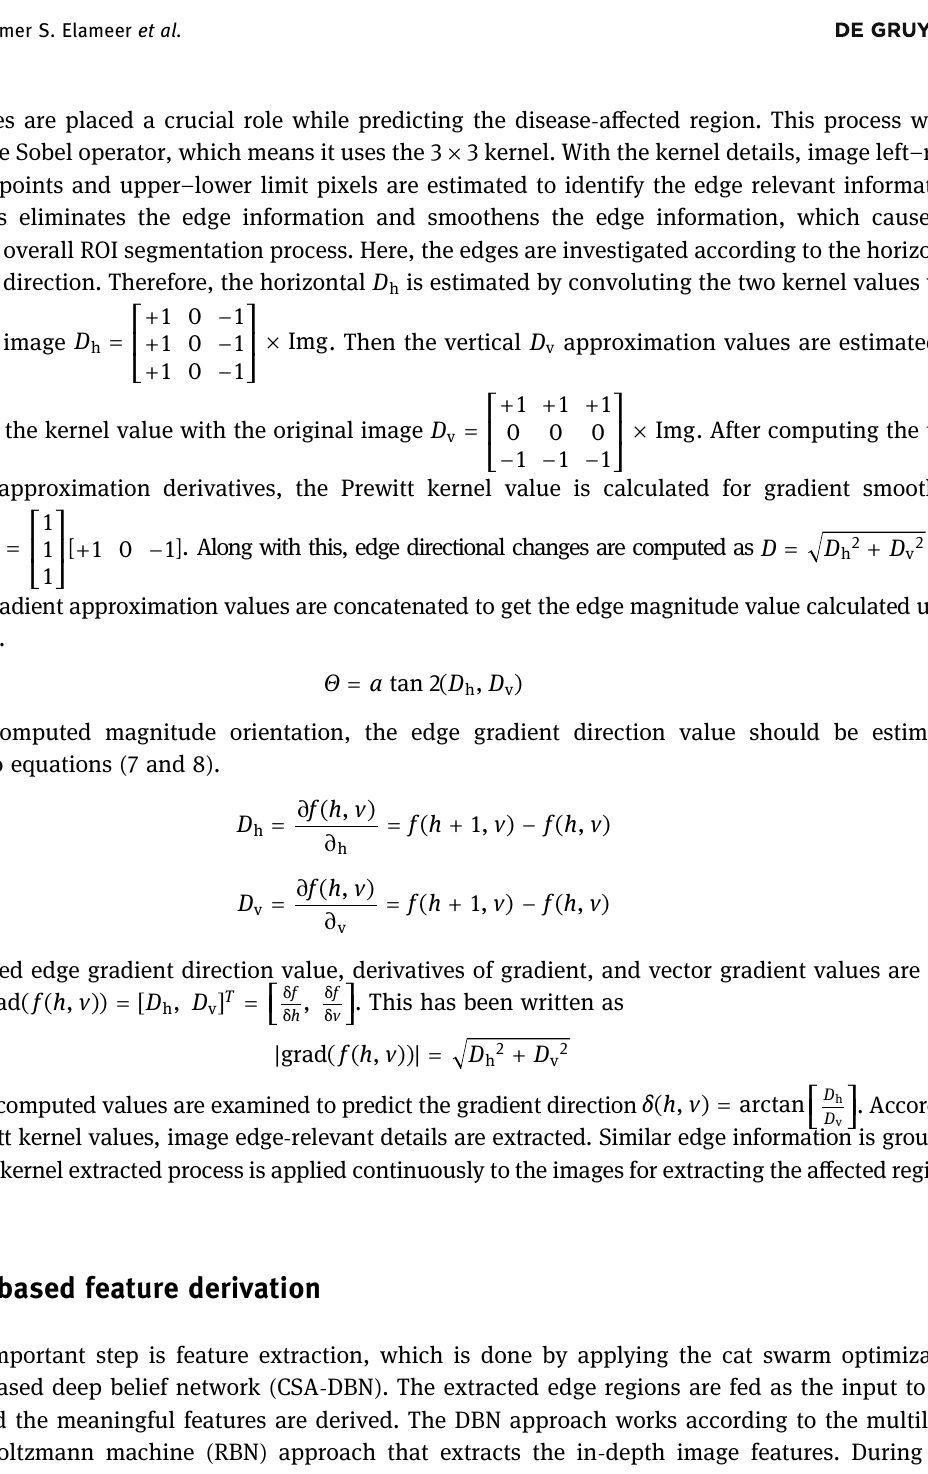
Figure 3. The RBN has the connection between the entire visible layer and hidden layer but having